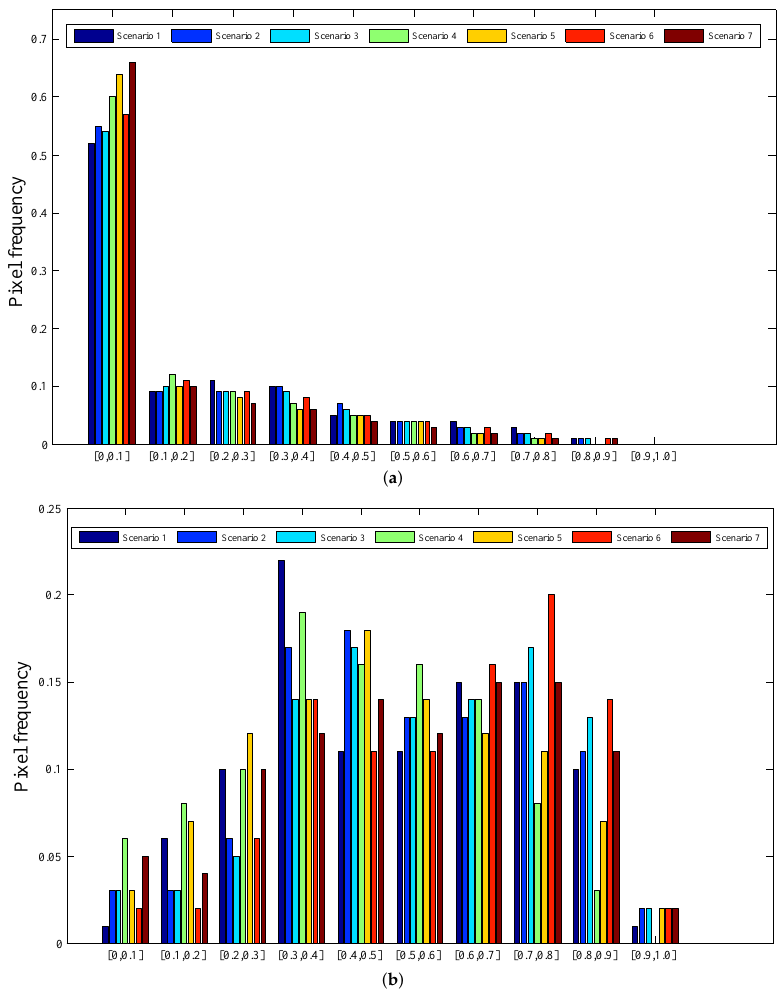
Figure 7. Distribution of H for the corrected classified test samples ( a ) and incorrect predictions ( b ) as resulted from different scenarios of input